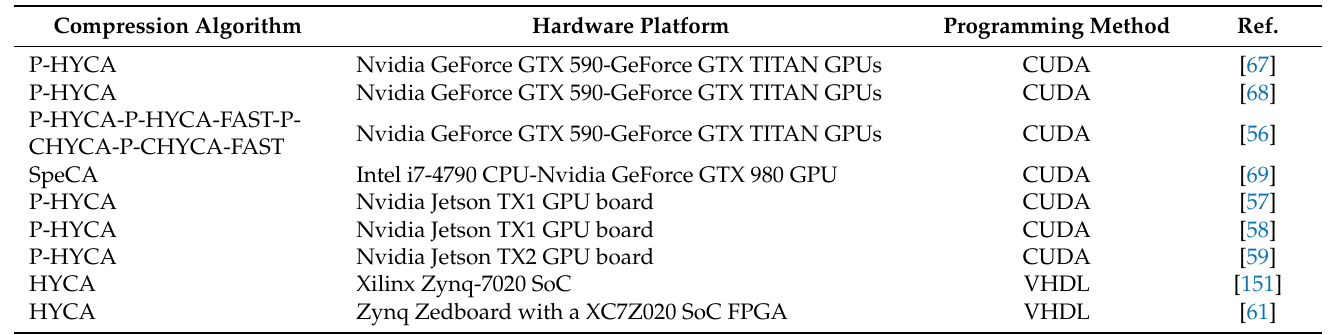
Table 6. List of studies on compressive sensing-based compression systems of hyperspectral images and their hardware platforms.